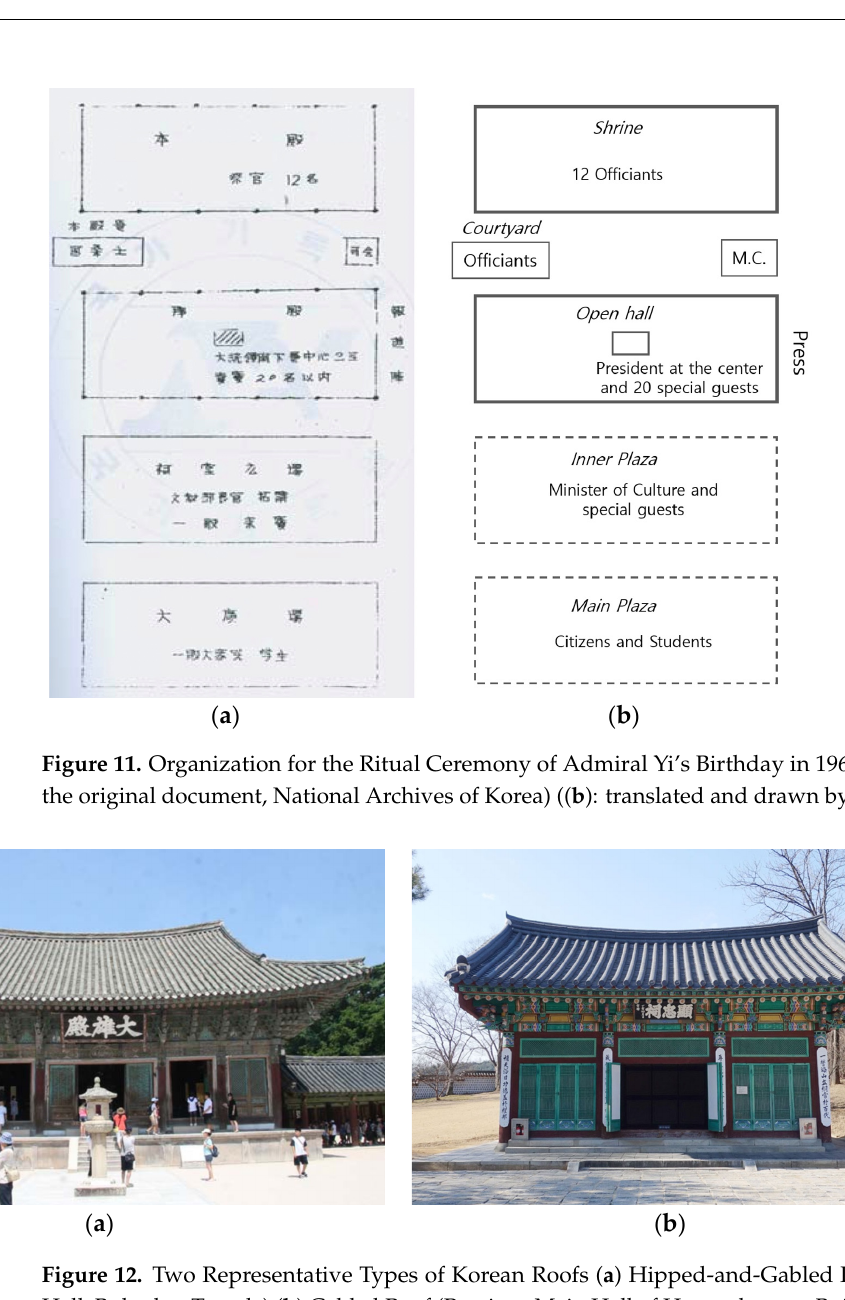
Figure 10. The Main Hall and Surrounding walls (source: Cultural Heritage Administration).